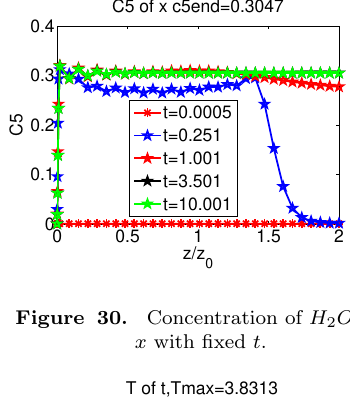
Figure 29. Concentration of CO vs. x with fixed t .